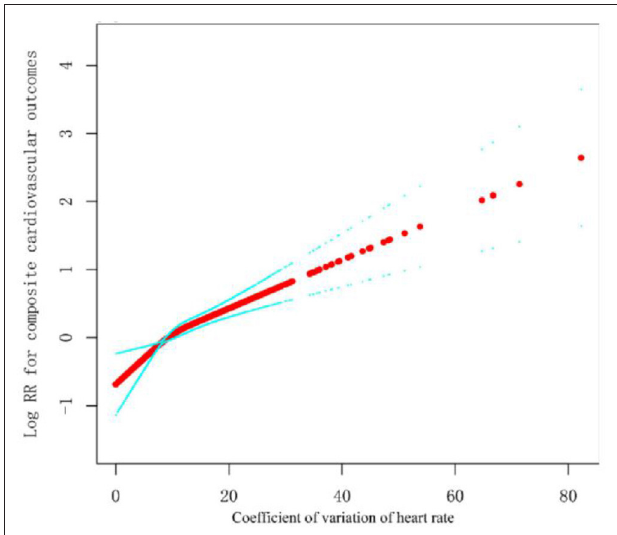
FIGURE 2 | Smooth spline curves of visit-to-visit heart rate variability for the estimation of risk of composite cardiovascular outcomes. The red dot is Log HR, and the blue dot is 95%CI.All covariables in Model 3 were adjusted.